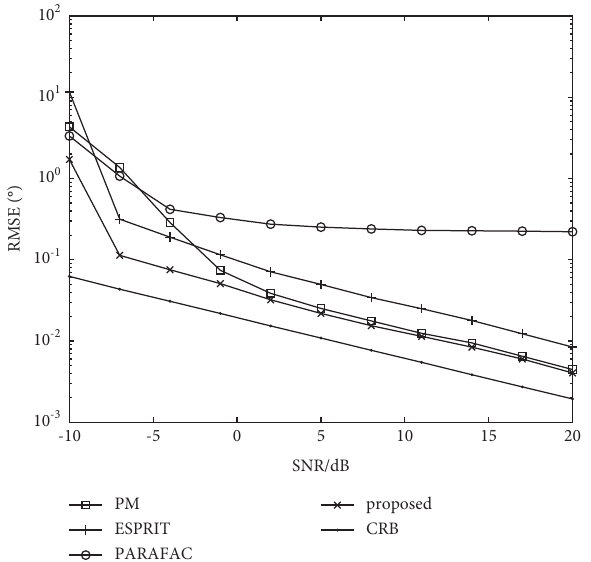
Figure 6: DOA estimation of different algorithms versus SNR.